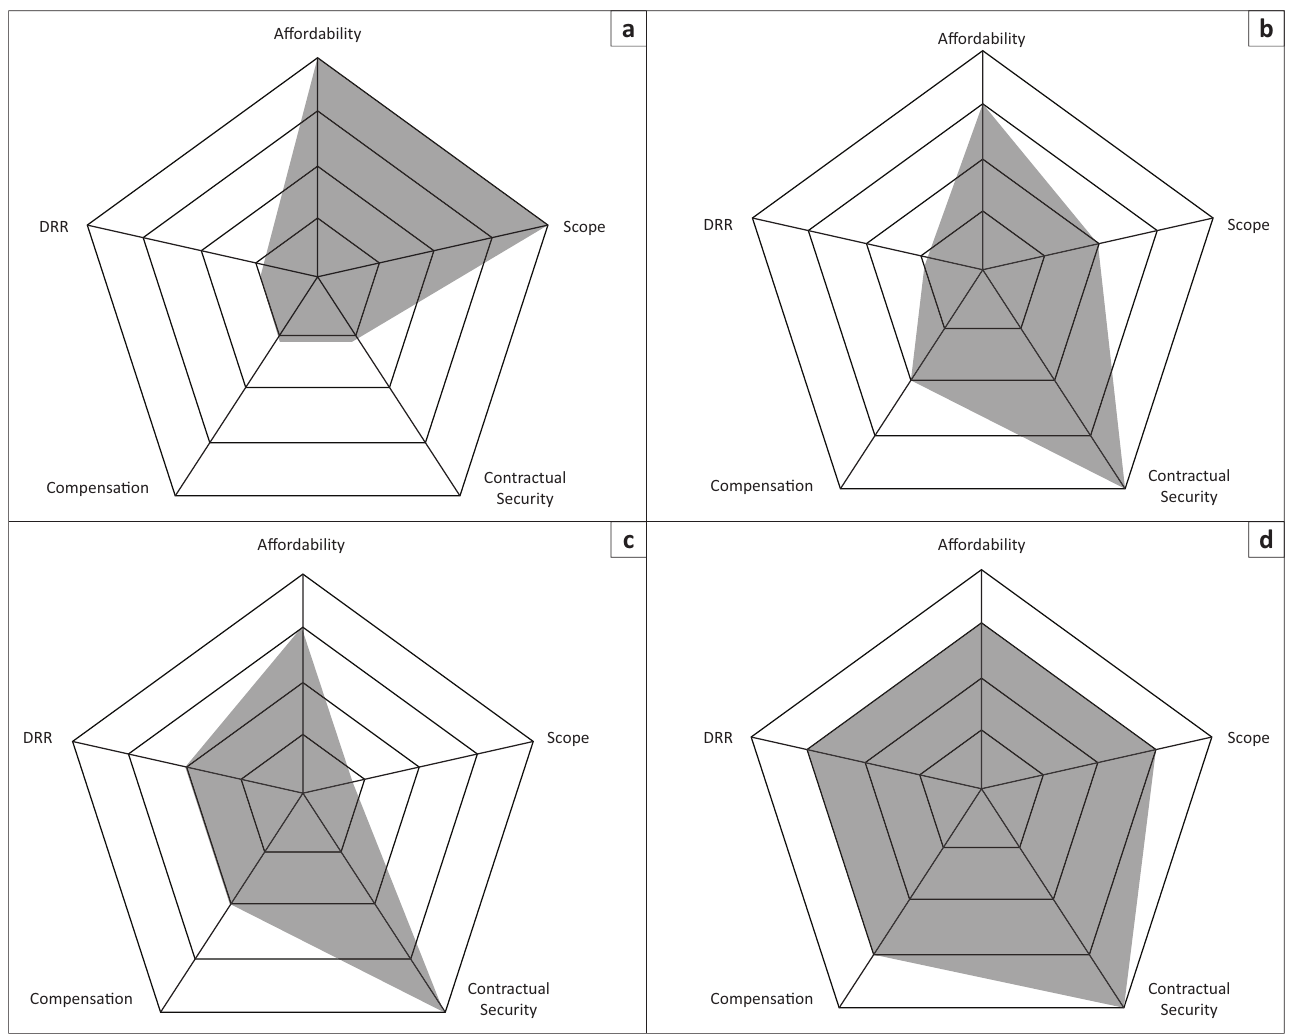
FIGURE 1: Radar charts for public insurance mechanisms. (a) Post-disaster assistance, (b) catastrophe-linked securities (Mexico Catastrophe Bond), (c) multi-country pool insurance (Caribbean Catastrophe Risk Insurance Facility) and (d) compulsory insurance (Turkish Catastrophe Insurance